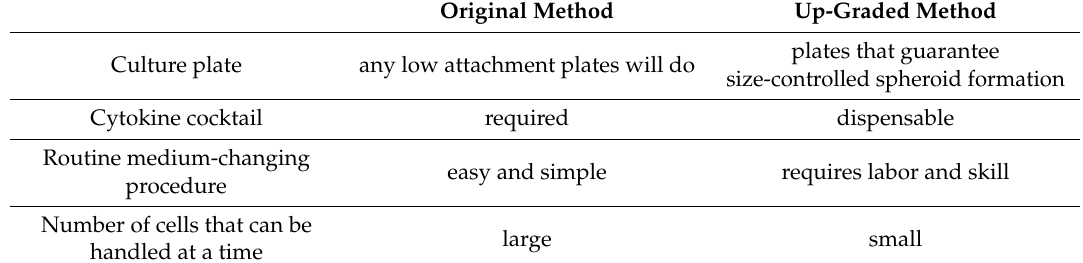
Table 1. Comparison between the two methods.